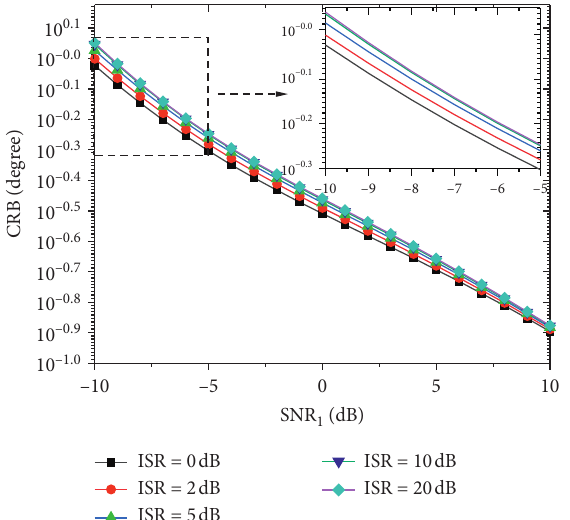
Figure 6: The CRBs of the weak source against the angular sep- 1 under dif- aration under different